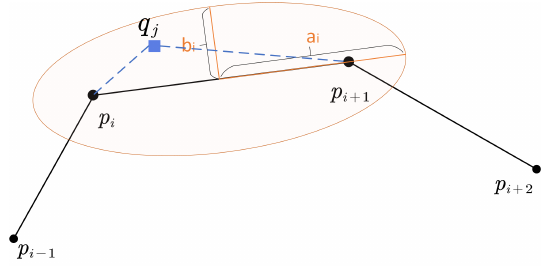
Figure 10. A anchor point and its matching